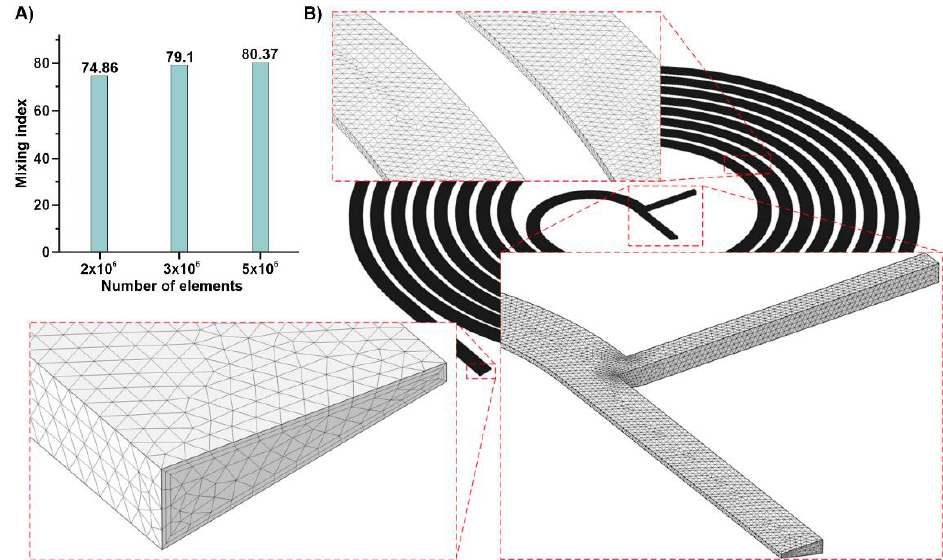
Figure 2. The information for the applied grids. ( A ) The grid independence study; ( B ) The selected grid is shown in detail in several regions of the channel.